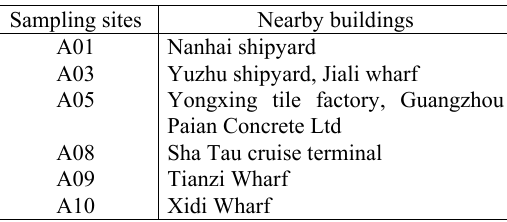
Table 2. Abnormal sites of the front-channel and the buildings